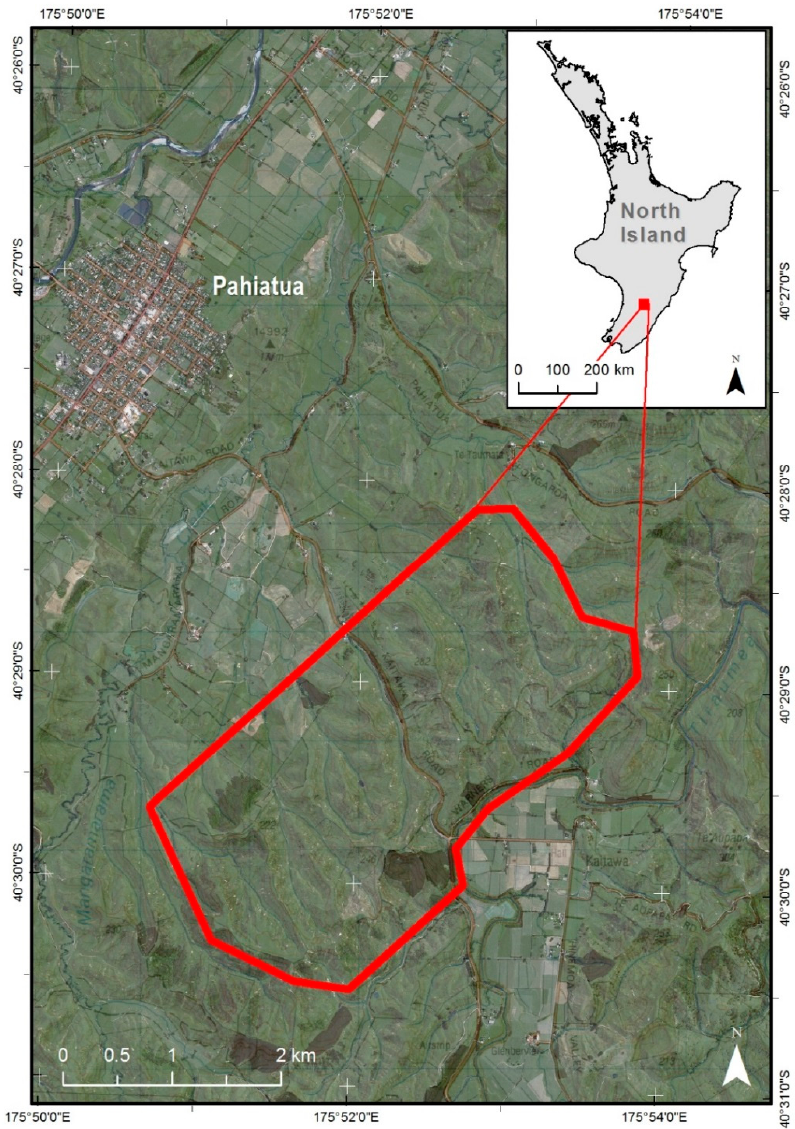
Figure 1. Location of the study area in southeastern North Island, New Zealand.